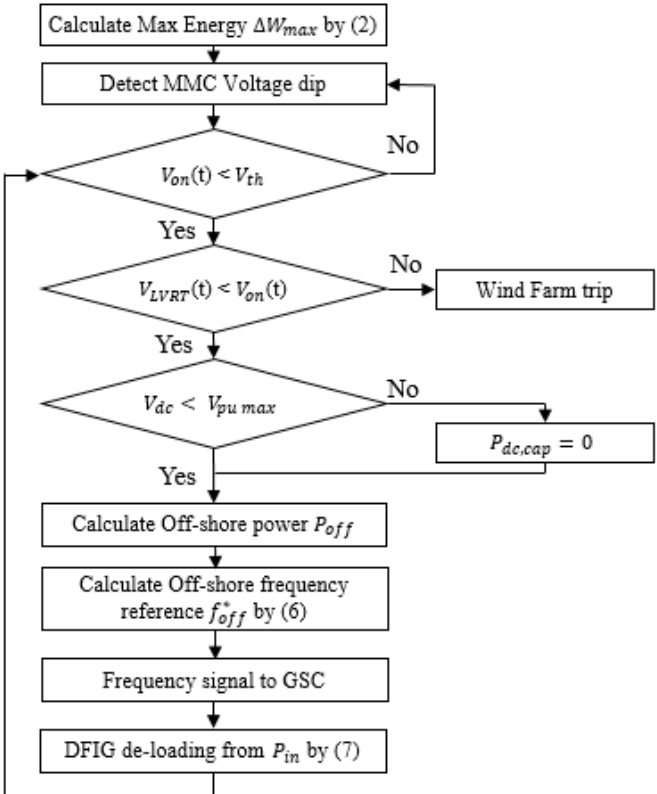
Figure 3. Coordinated droop control algorithm.